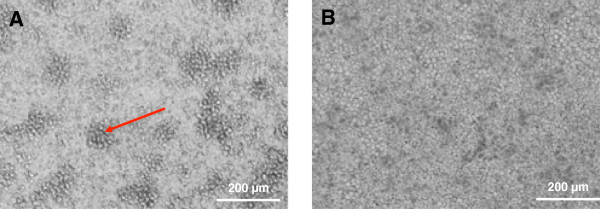
Colonies of differentiated THP-1 cells and HMC-1 cells on top of epithelial A549 cells. A: Brightfield image of THP-1 cells and HMC-1 cells that form colonies on top of A549 epithelial cells. The red arrow indicates a representative colony. B: Same transwell insert cultivated at the ALI without showing colonies. (Magnification: 200x).